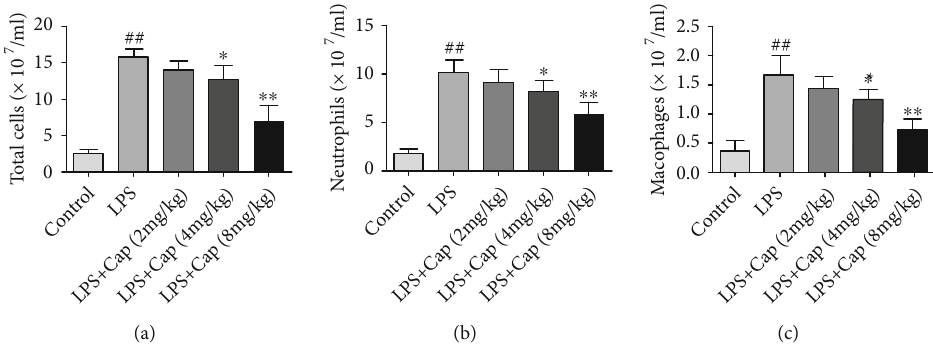
Figure 6: Cap inhibits in fl ammatory cell accumulation in neonatal rats with acute lung injury. The number of total cells (a), neutrophils (b), and macrophages (c) in BALF. Results are expressed as the mean ± standard deviation ( n = 8 ). ## P < 0 : 01 compared to the control group; ∗ P < 0 : 05 and ∗∗ P < 0 : 01 compared to the LPS group.